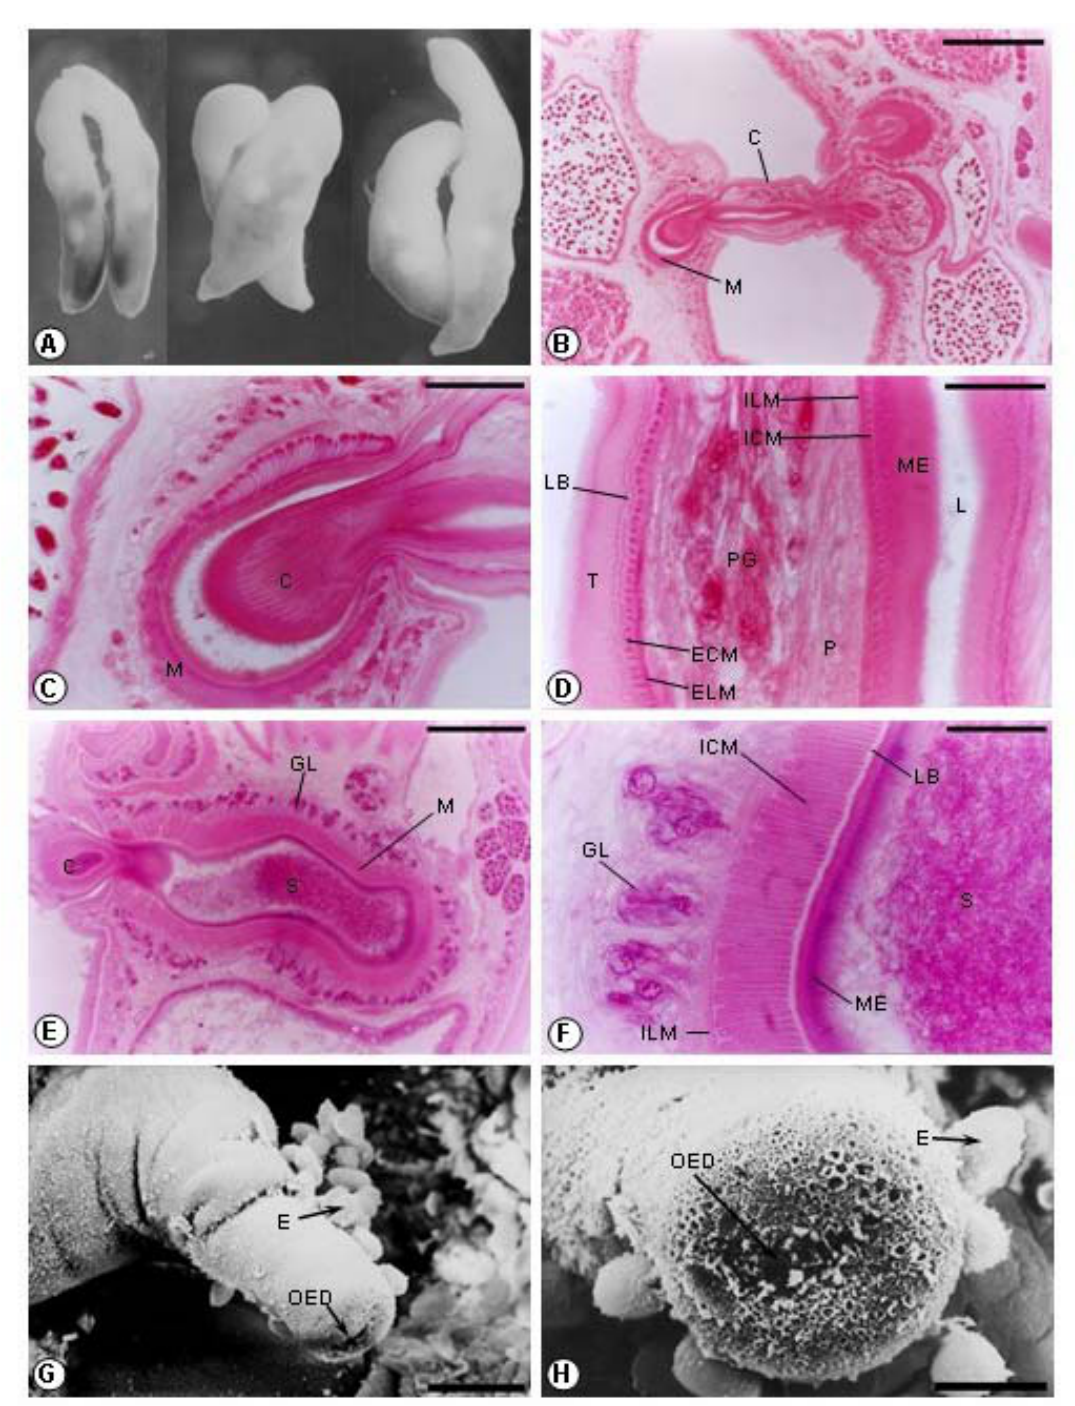
Figure 2. Three cases of copulation in O. fonsecai